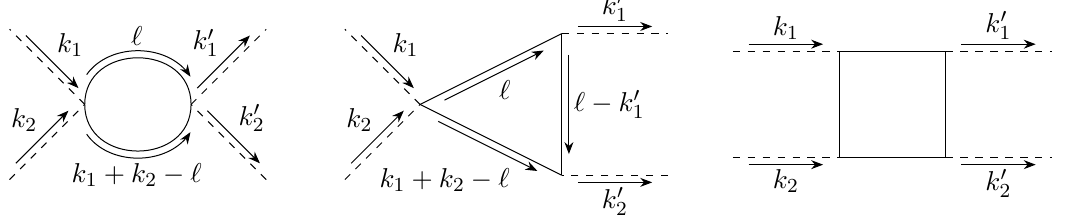
Figure 17 . We consider the momenta of incoming dilatons be k 1 and k 2 and the momenta of outgoing dilatons be k 0 and k 0 . In the total amplitude contribution we also need to add the 1 2 contributions of two topologically in-equivalent diagrams for the above individuals which we can easily read off using crossing